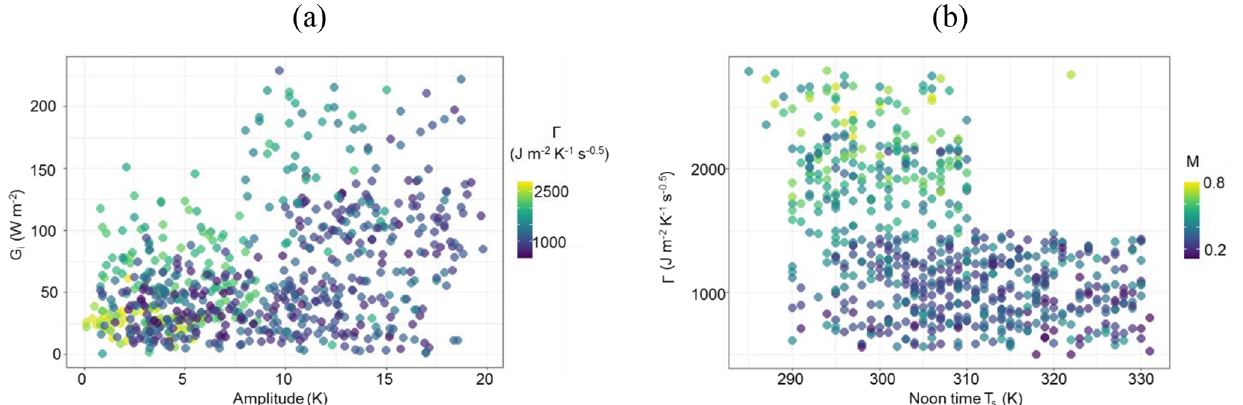
Figure 14. Response plots among parameters of the TI-based G i model, such as (a) G i versus amplitude ( A ) for varying (cid:48) and (b) noontime T S versus (cid:48) with varying M